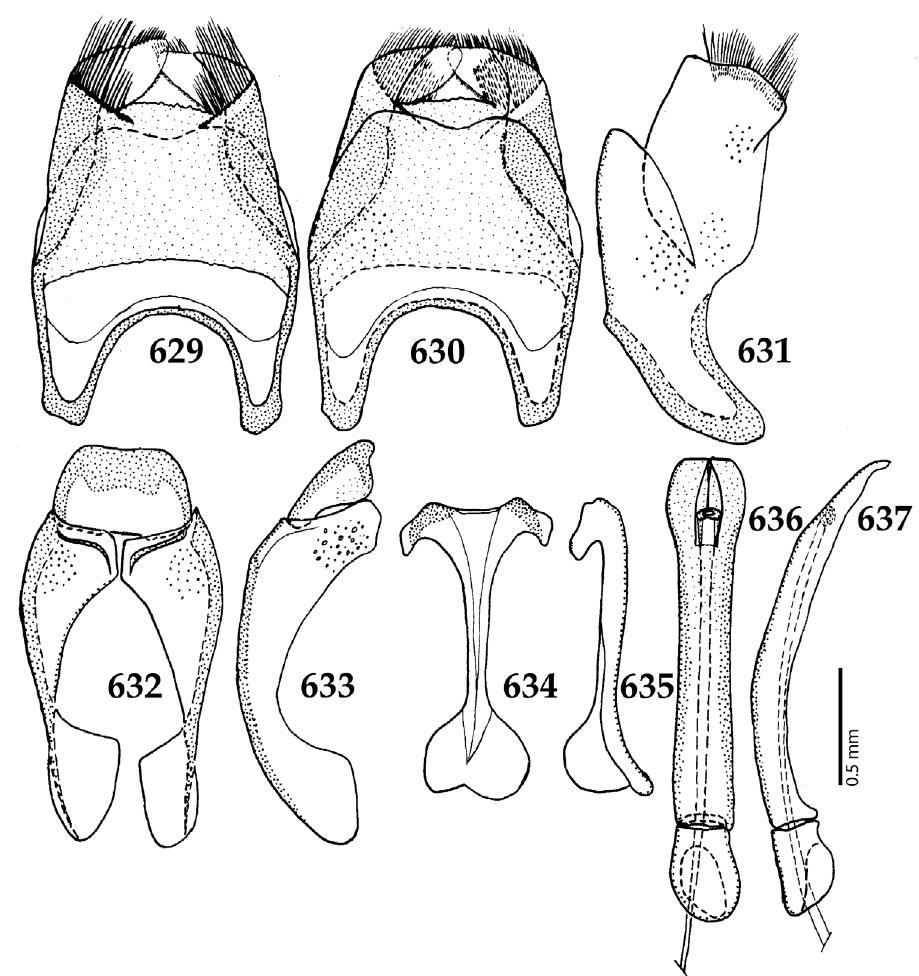
ventral view 630 ditto, dorsal view 631 ditto, lateral view 632 male terminalia: 9 th + 10 th tergites, dorsal view 633 ditto, lateral view 634 male terminalia: spiculum gastrale, ventral view 635 ditto, lateral view 636 male terminalia: aedeagus, dorsal view 637 ditto, lateral